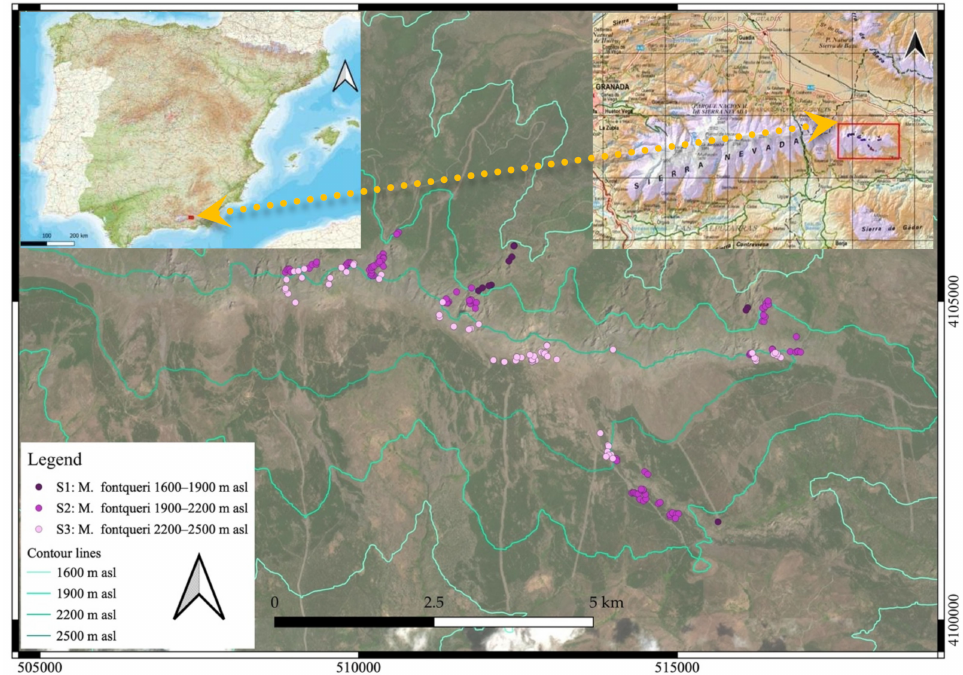
Figure 6. Distribution range map of Moehringia fontqueri . Detail of the distribution of occurrences in Sierra Nevada divided by altitude (S1, S2 and